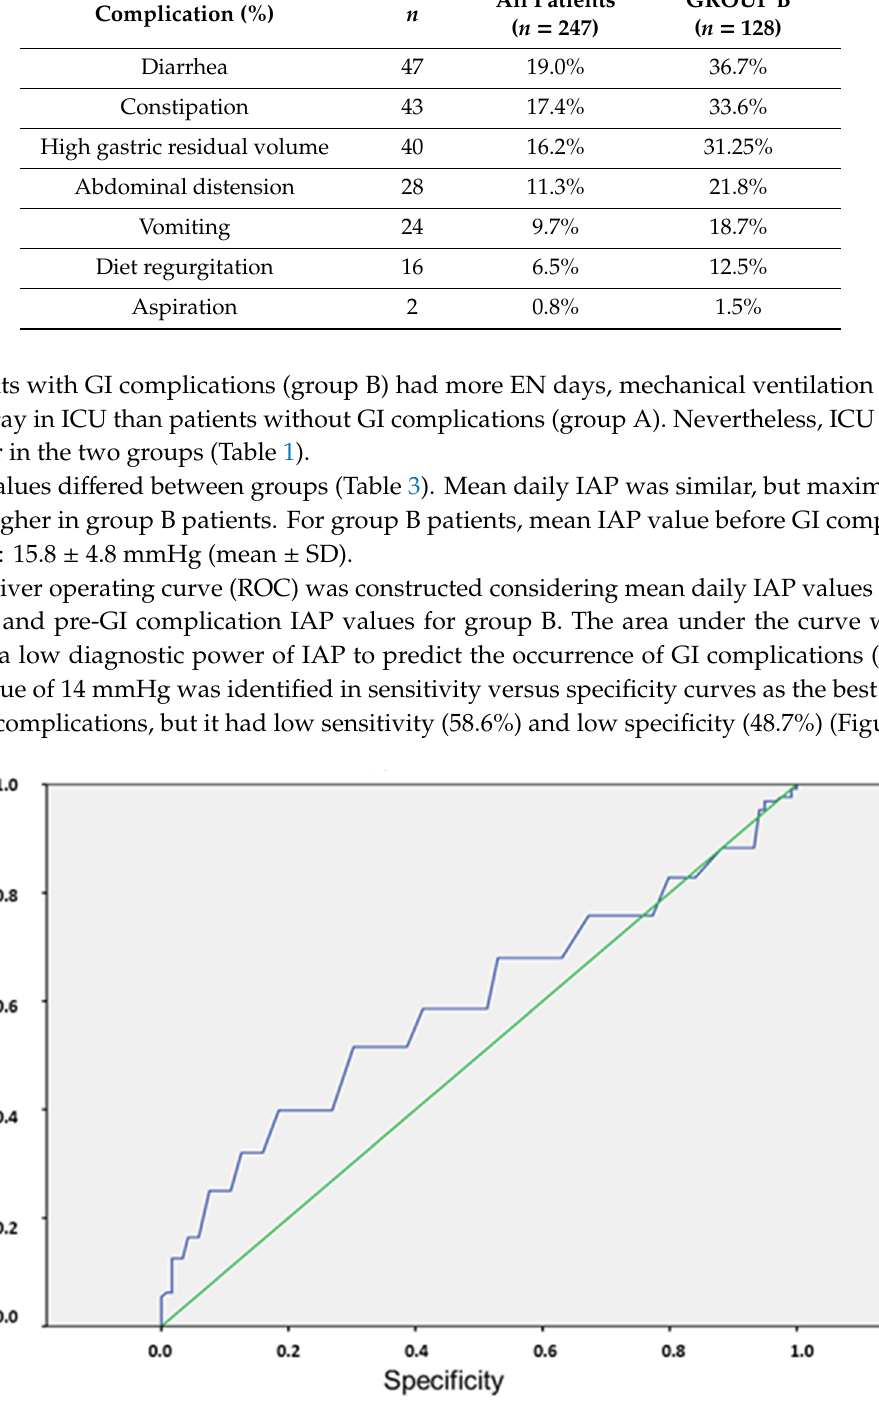
Figure 2. Sensitivity and specificity of maximum intraabdominal pressure (IAP) in predicting enteral nutrition intolerance. The best IAP cut-off of 14 mmHg showed a sensitivity of 58.6% and a specificity of 48.7%. 4. Discussion